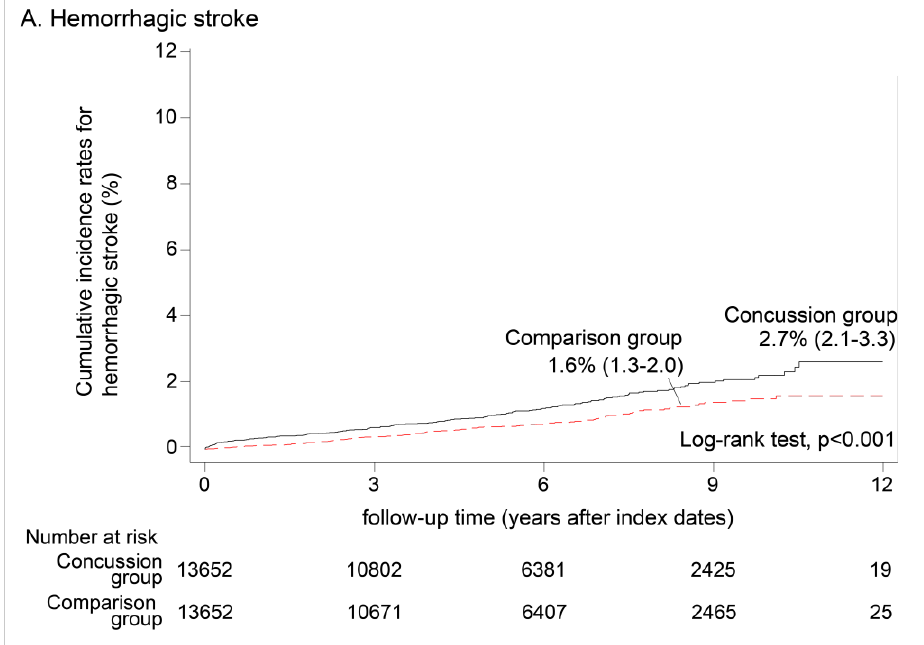
Figure 3. Cumulative incidence rates of ( A ) hemorrhagic and ( B ) ischemic strokes of the concussion group and the comparison group ( n = 27,304, 1998–2005).